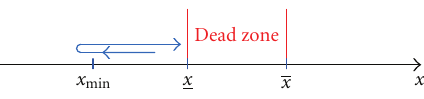
Figure 1: Sketch map for the river crossing